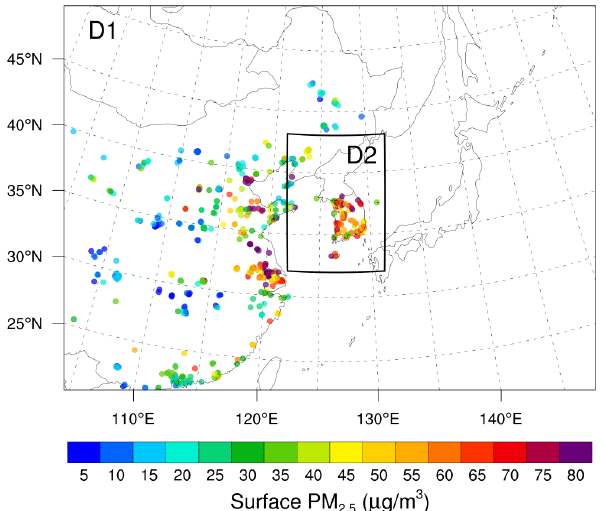
Figure 1. The surface observation network in two model domains. A black box indicates domain 2 (D2) over South Korea, nested down from domain 1 (D1). Colored dots indicate surface PM 2 . 5 observations assimilated on 26 May 2016 at